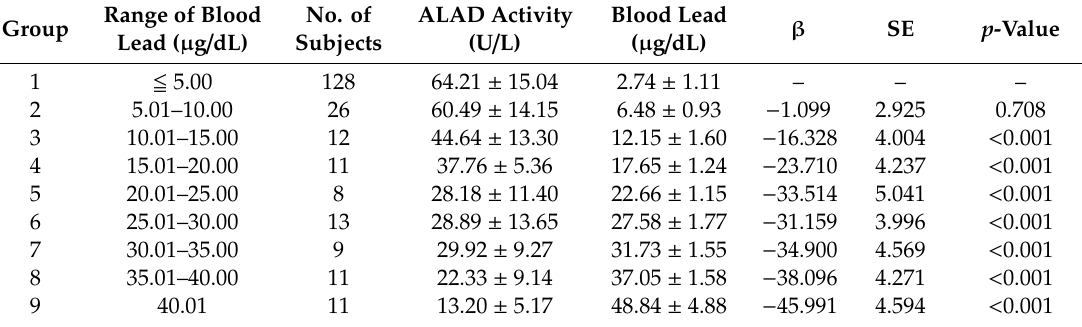
Table 3. Multiple linear regression analyses for association with ALAD activity and blood lead level (ALAD 1-1 type only, n = 229). Adjusted for gender, age, BMI, fasting glucose, smoking, and drinking